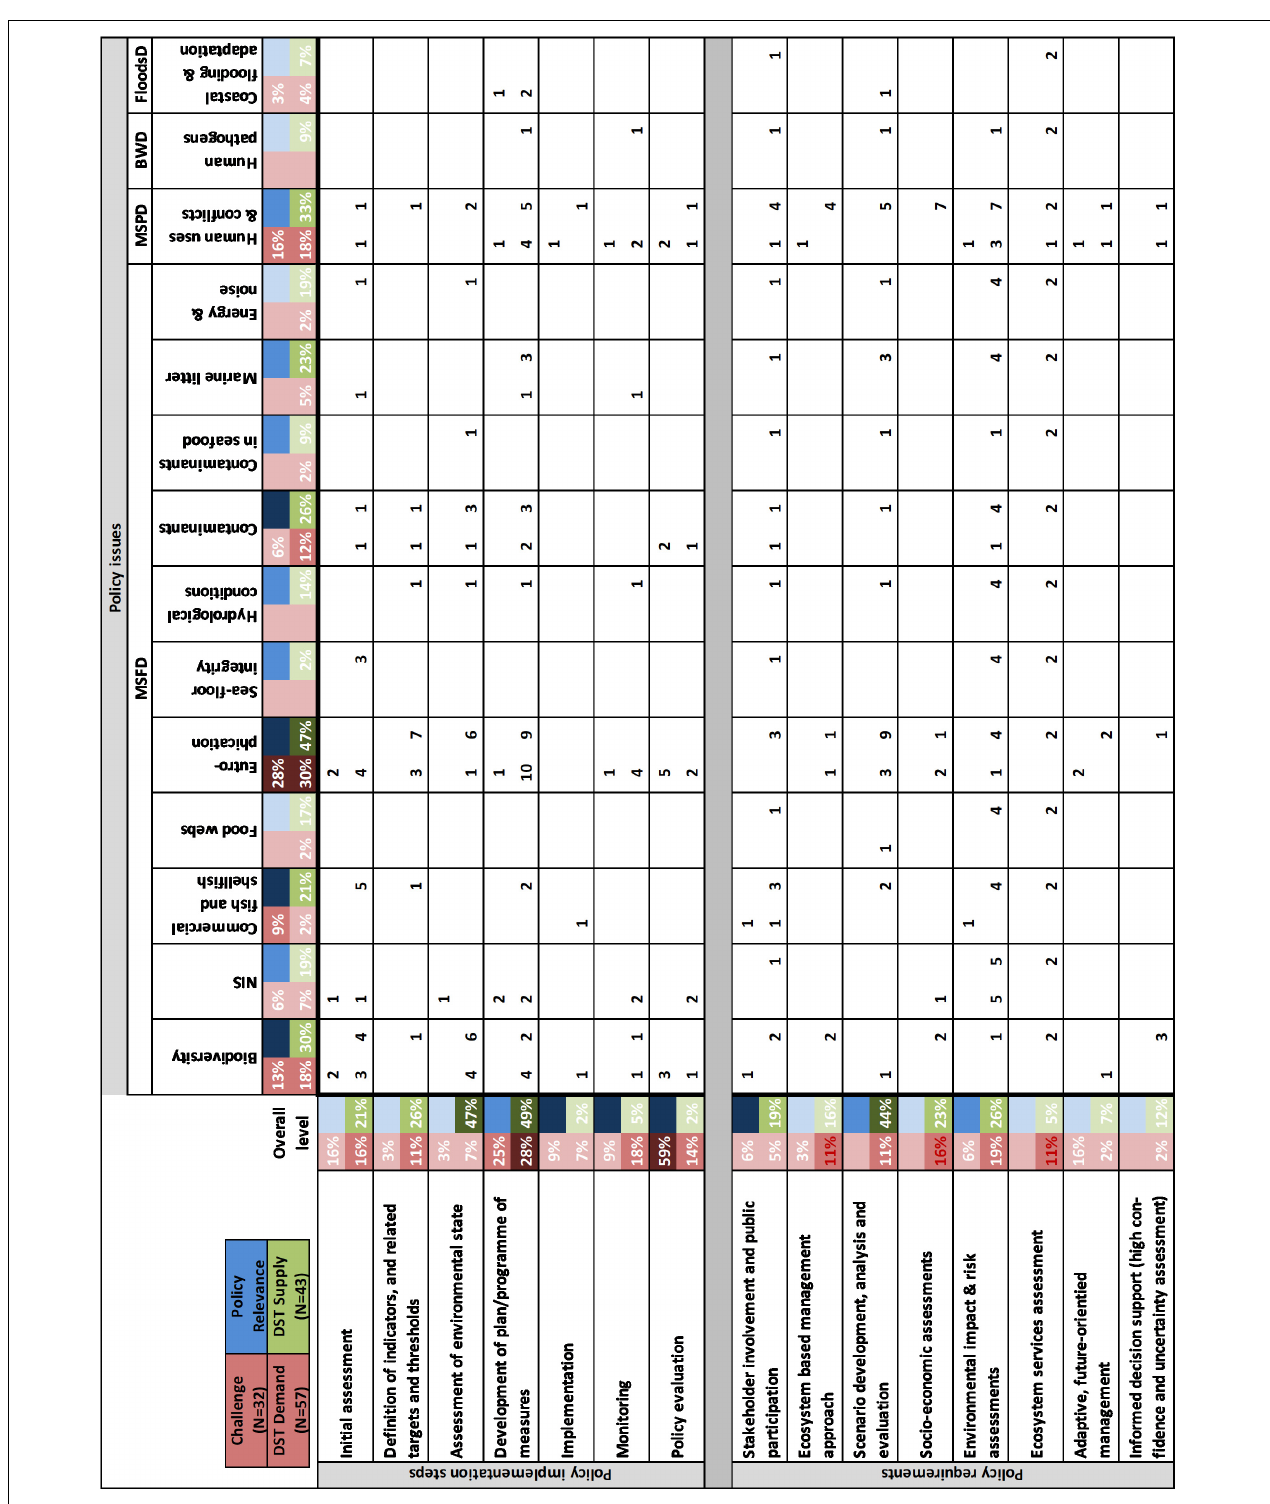
FIGURE 3 | The synthesis-matrix structure and policy relevance (indicated in blue) resulted from the policy review. Numerical values presented in the synthesis-matrix summarize the results of the end-user survey and DST review. End-user challenges are shown in the upper left corner of each square (red), DST demand in the lower left corner (red), and DST supply in the lower right corner (green). Different shades for each color on the overall level categorize each section on a categorical scale from low (light colors) to high (dark colors).